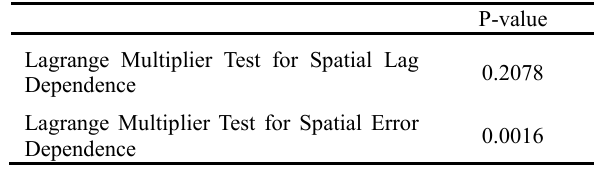
Table 6 . Moran’s I for residuals of the spatial error